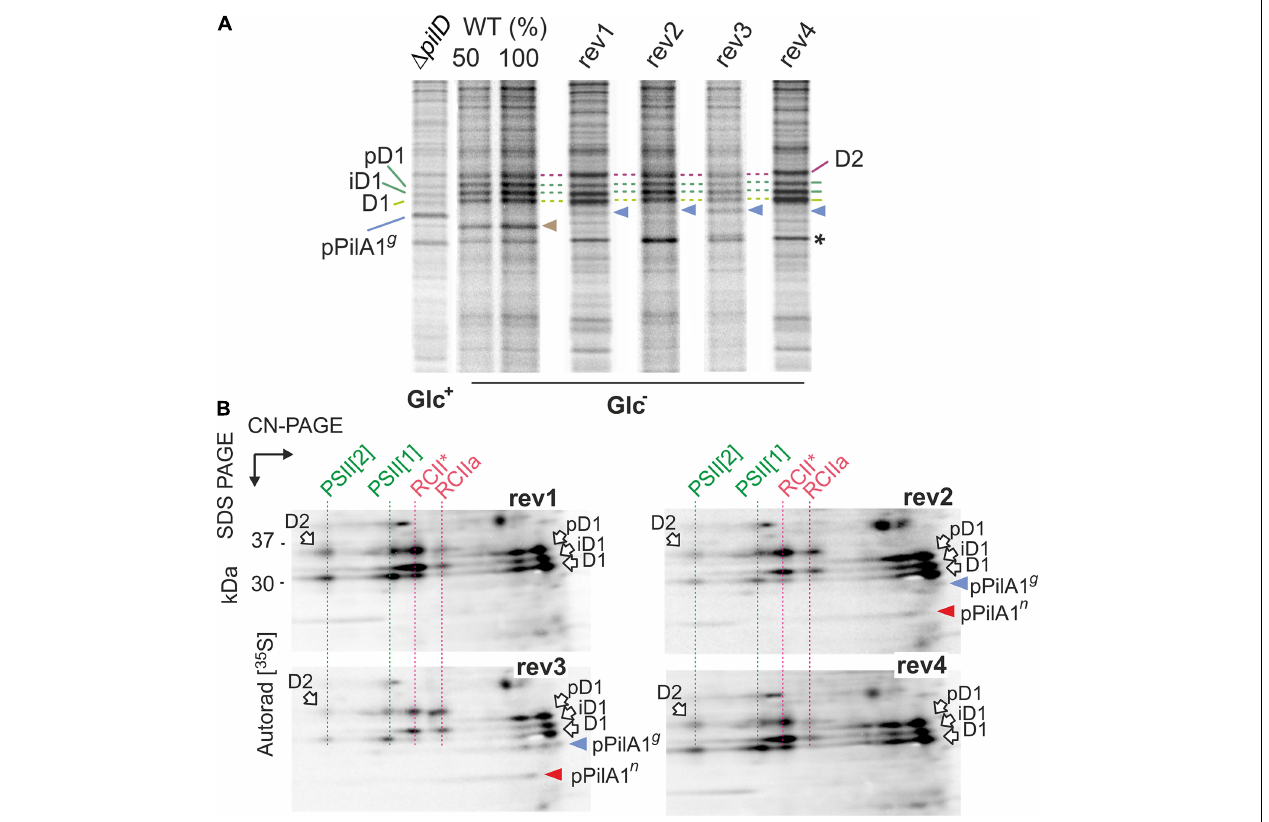
FIGURE 6 | Synthesis of prepilin and PSII complexes in WT, (cid:49) pilD mutant, and (cid:49) pilD revertant strains. (A) WT and rev strains from Glc − conditions and the (cid:49) pilD (Glc + ) were radiolabeled with a mixture of [ 35 S]-Met/Cys using a 20-min pulse. Isolated membrane proteins were separated by 16–20% SDS-PAGE; 1 µ g of Chl was loaded for each strain. The gels were stained with Coomassie Blue ( Supplementary Figure 5 ), dried, and the labeled proteins were detected by phosphorimaging. The signal of pPilA g is indicated by a blue arrowhead and radiolabeled PilA1 by brown arrowhead. Asterisk indicates an intensively labeled band that has the same mobility in the gel as the pPilA n . All three forms of radiolabeled D1 subunit are marked by green dashed lines; pD1 and iD1 indicate unprocessed and partially processed forms of the D1 subunit. D2 subunit is marked by a purple dashed line. (B) The radiolabeled rev1-4 samples (4 µ g of Chl) were separated by 2D CN/SDS-PAGE, stained by SYPRO Orange stain (see Supplementary Figure 6 for the stained gels) and blotted onto a PVDF membrane. The labeled proteins were detected by phosphorimaging and the signal of prepilins was verified by immunodetection ( Supplementary Figure 7 ). Dashed red lines highlight PSII assembly intermediates RCIIa and RCII* (Yu et al., 2018), green lines highlight labeled PSII subunits assembled into monomeric and dimeric PSII. The signals of pPilA g and pPilA n are indicated by blue and red arrowheads,